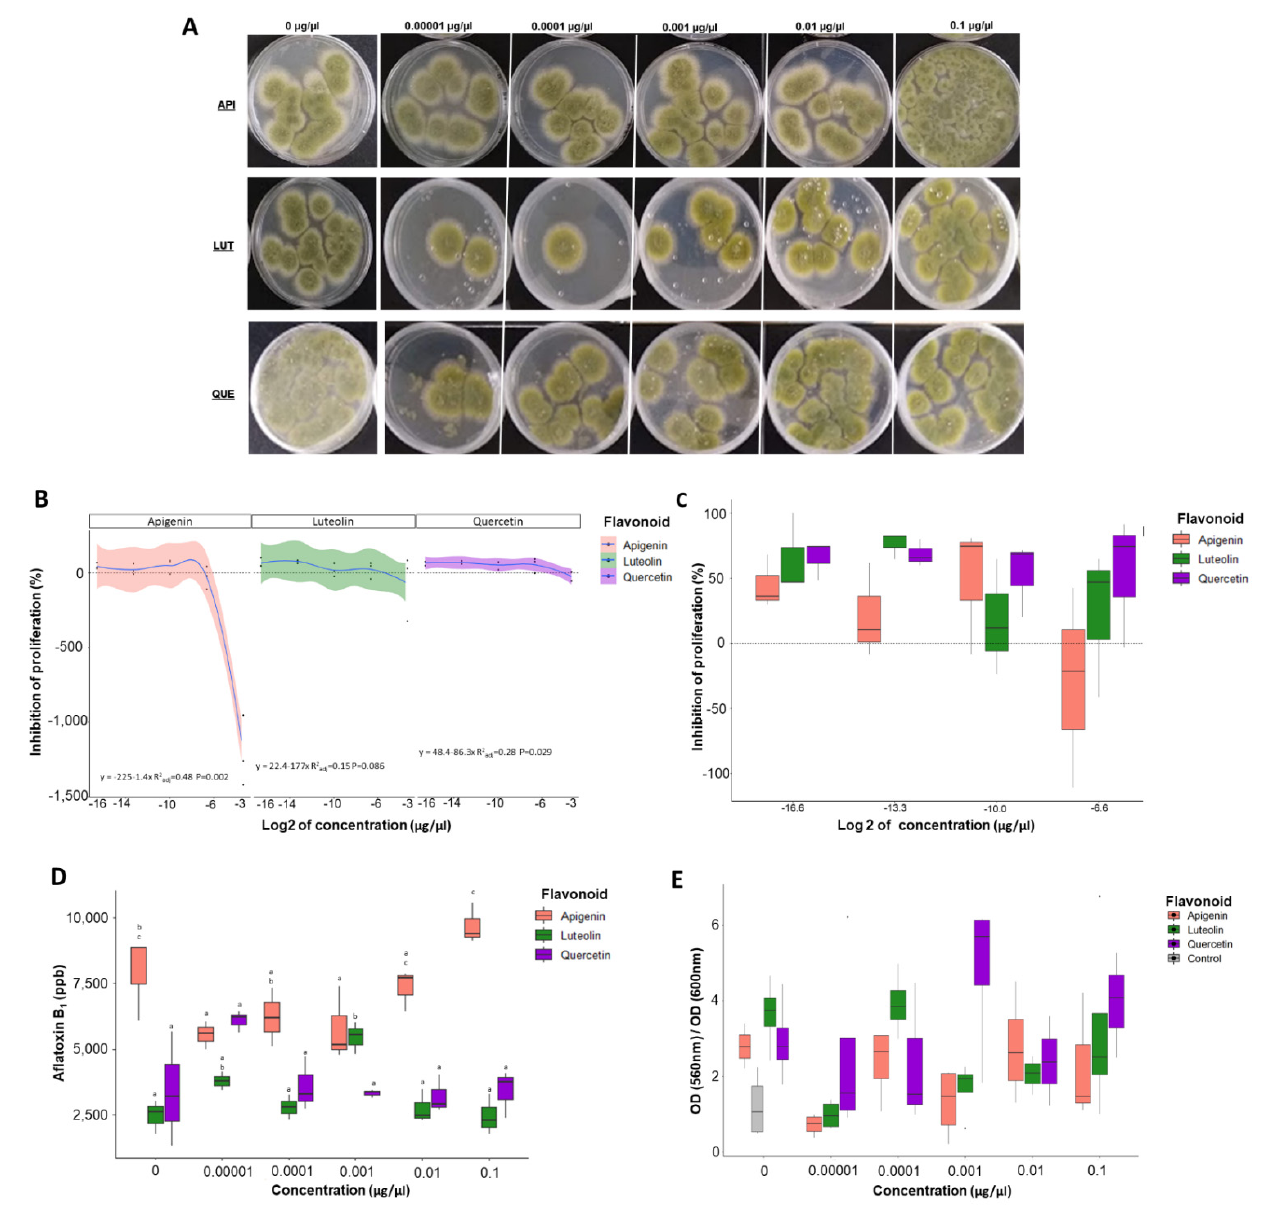
Figure 1. Effect of flavonoids on proliferation, aflatoxin production, and cell metabolism of A. flavus 3357. Biological assays performed with AF3357 strain exposed to apigenin, luteolin, and quercetin at 0 (1% DMSO only), 0.00001, 0.0001, 0.001, 0.01, and 0.1 µg/µL concentrations. ( A ) Pictures of Petri dishes from proliferation assays after 3 days of incubation. ( B ) Regression analysis of inhibition of proliferation and flavonoid concentration. Regression formula includes adjusted R 2 and p -value; log 2 concentration was only used for scaling, not for regression. ( C ) Box plots of inhibition of proliferation (highest concentration (0.1 µg/µL) was excluded). ( D ) Concentration of aflatoxin B1 (ppb). ( E ) MTT assay results expressed as the ratio of OD 560 nm/OD 600 nm. Key color legend represents chemical used; salmon: apigenin, green: luteolin, purple: quercetin, and gray: control (0% DMSO). Different letters over box plots represent significant difference according to Tukey HSD assay ( p < 0.05) for aflatoxin B 1 performed separately by flavonoid. Box plot whiskers depict the maximum and minimum without outliers, and the box depicts median and first and third quantile distribution. n = 3 per treatment. For Figure 1E, the dots are outliers .